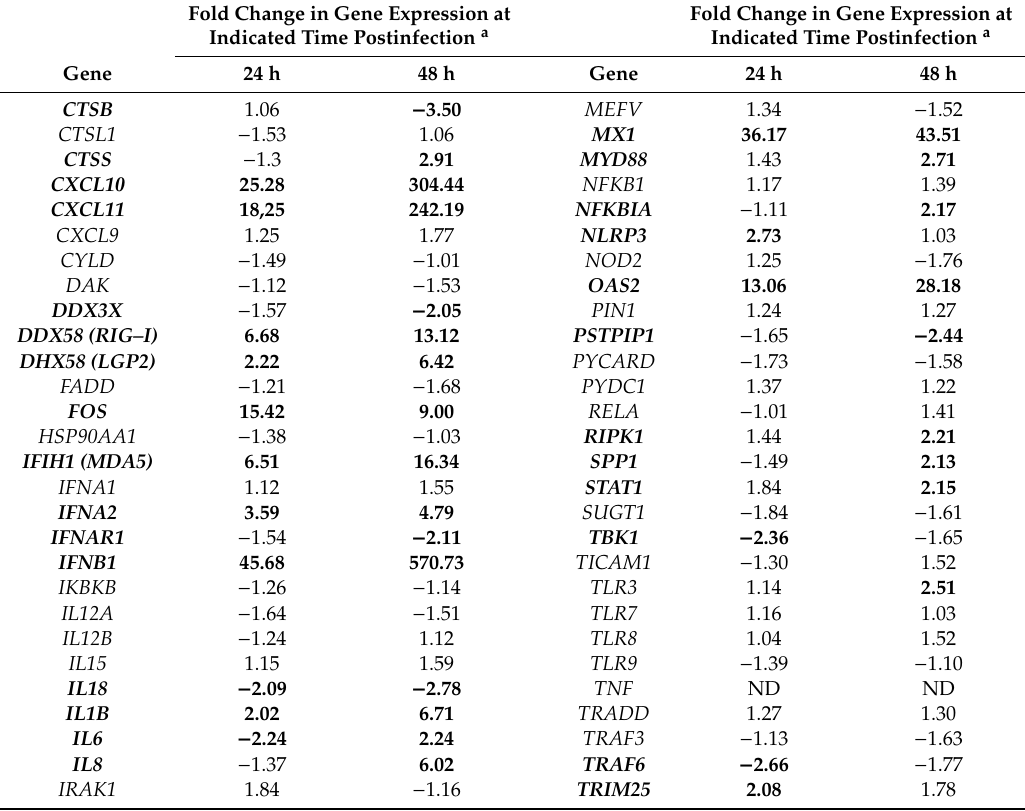
Fold Change in Gene Expression at Indicated Time Postinfection a